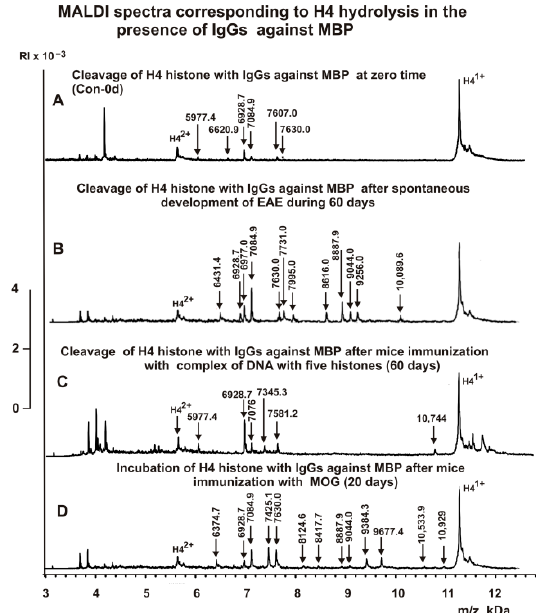
Figure 5. MALDI spectra corresponding to products of H4 histone (0.8 mg/mL) hydrolysis in the presence of IgGs against MBP (( A – D ) 0.045 mg/mL) at zero time of the experiment (( A ) Con-0d-MBP), after spontaneous development of EAE during 60 days (( B ) Con-60d-MBP), 60 days after mouse immunization with DNA–histones complex (( C ) DNA-60d-MBP), and 20 days after mouse treatment with MOG (( D ) MOG-20d-MBP).